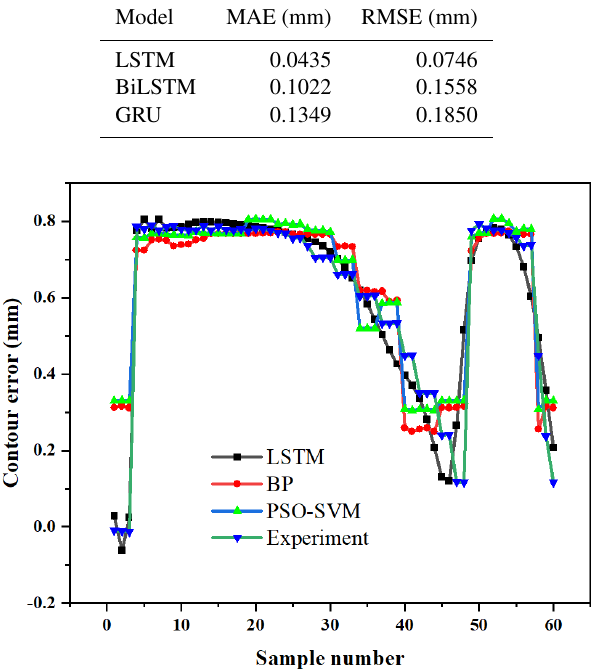
Figure 2. Comparison of predicted values of LSTM, BP, and PSO- SVM (particle swarm optimized support vector